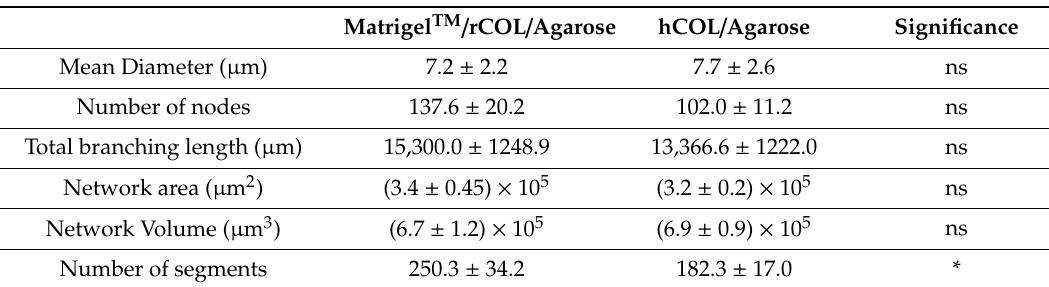
Table 1. Comparison of network parameters in agarose supplemented constructs. Constructs containing GFP-HUVECs and hASCs in hCOL / Agarose and Matrigel TM / rCOL / Agarose were cultured for 14 days. After cultivation period, z-stacks of constructs were taken at three random regions per construct using multiphoton microscopy. The stacks were processed with Imaris for 3D reconstruction and network quantification. Network parameters are presented as mean ± SD for: mean diameter, number of nodes, total branching length, network area, network volume, and number of segments. Data were analyzed with unpaired t -test. (*) p -value ≤ 0.05, ns: not significant.